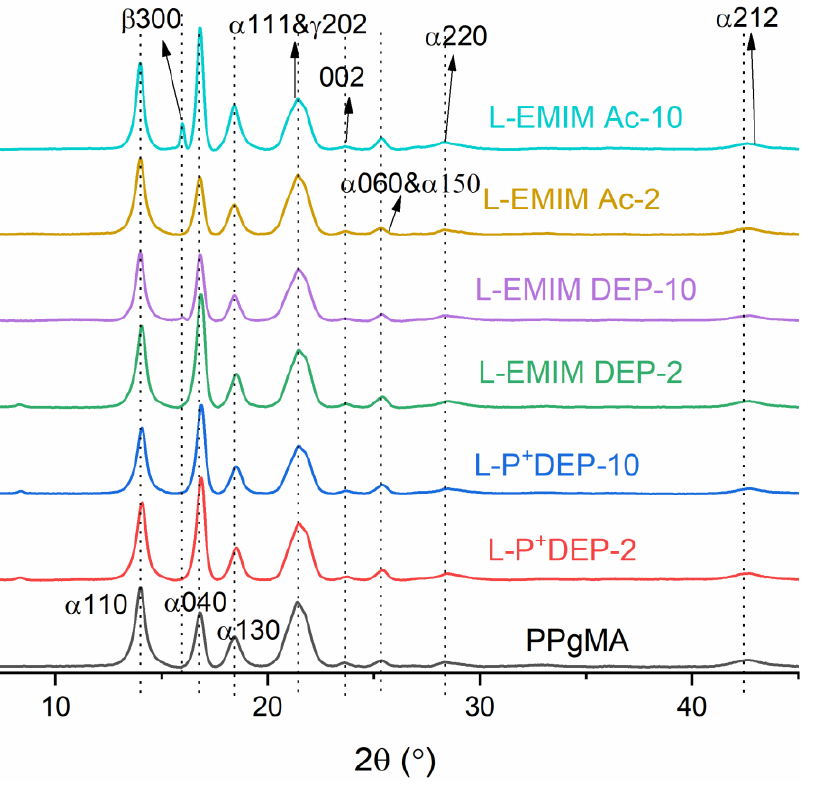
Figure 9. XRD diffraction patterns of PPgMA and its LIonomers based on various ILs at different IL Table 4. XRD analyses of the PPgMA and its related LIonomers (from Figure 9).